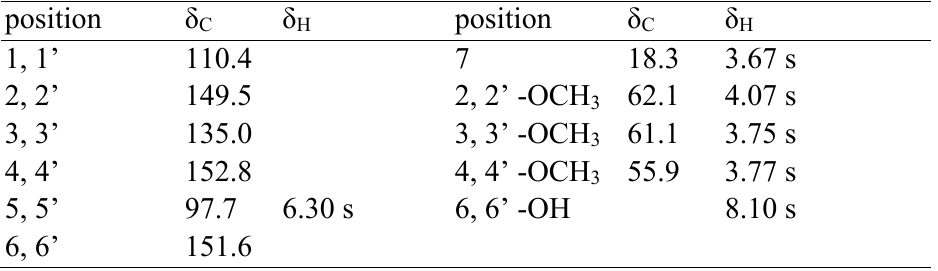
Table 1. 1 H- and 13 C-NMR spectral data for 1 (300 and 75 MHz in CDCl